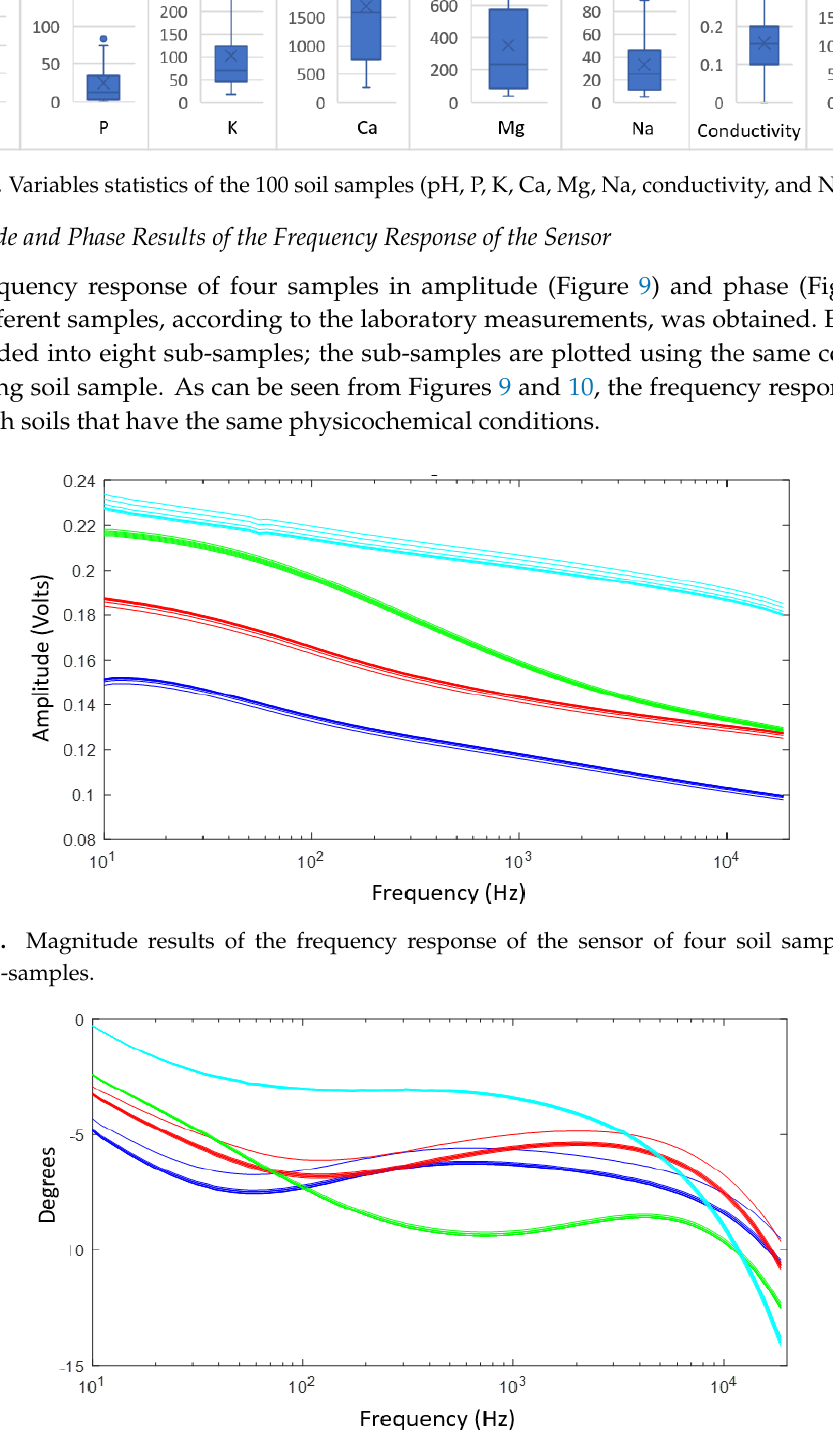
Figure 10. Phase results of the frequency response of the sensor of four soil samples and their sub- samples.